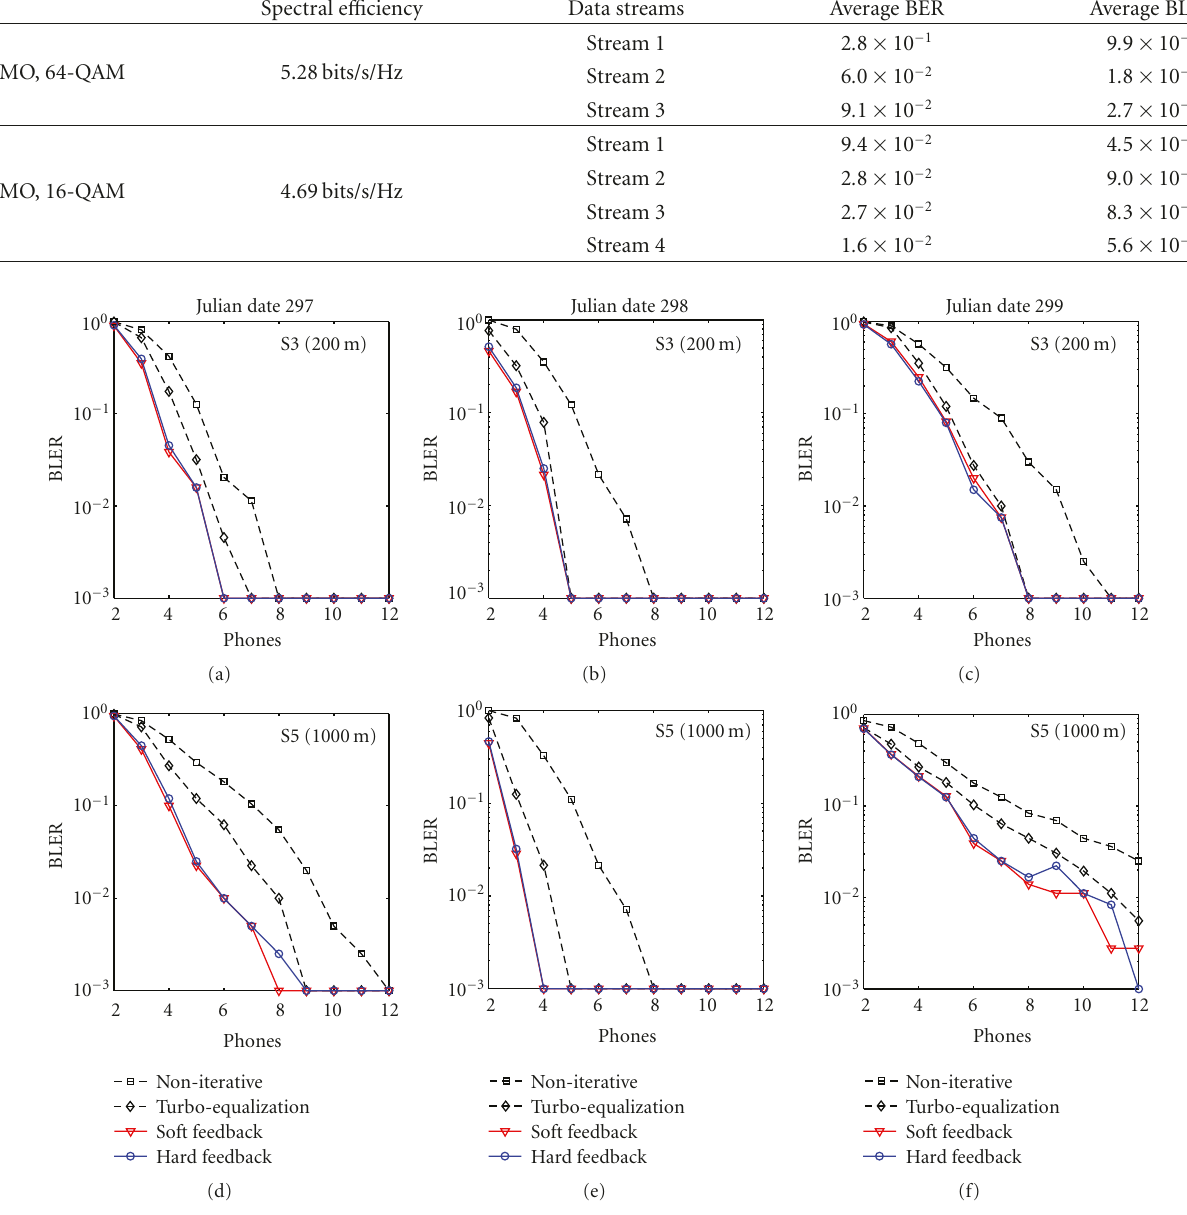
Figure 9: Experimental results from the SPACE08 experiment with N t = 2, QPSK, for S3 (200m) and S5